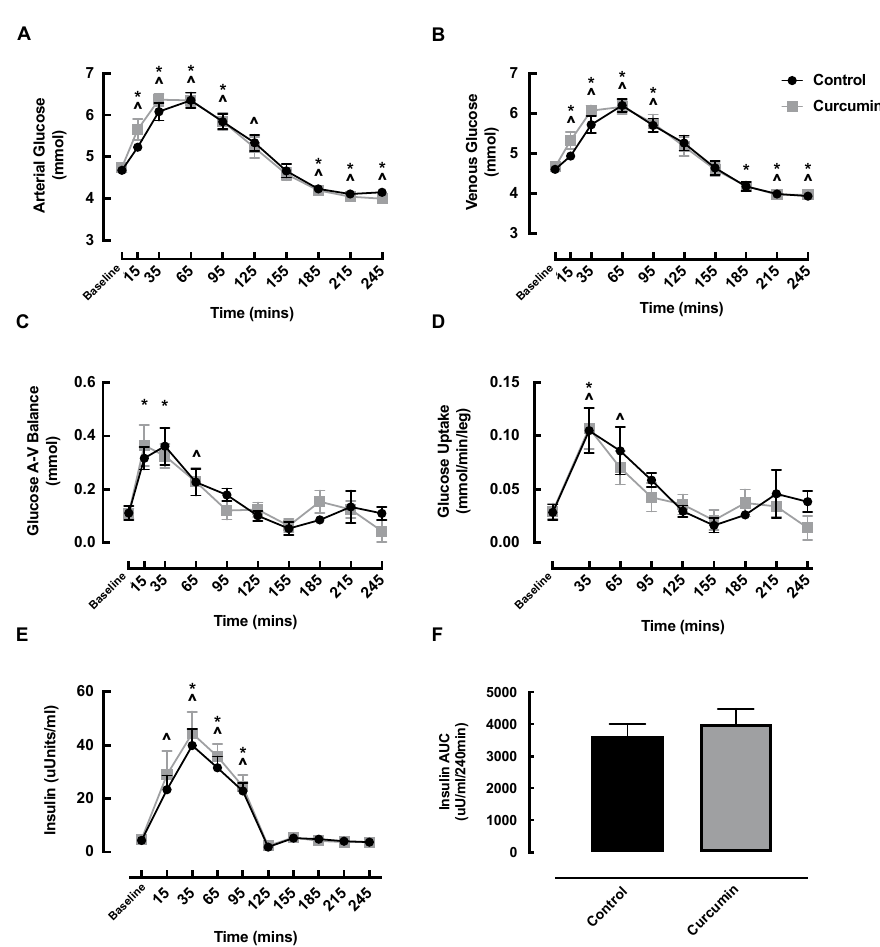
Figure 5. Effects of curcumin alongside oral nutritional supplement feeding on ( A ) arterial glucose; ( B ) venous glucose; ( C ) glucose A-V balance; ( D ) glucose uptake; ( E ) insulin; and ( F ) insulin area under the curve, in healthy older adults. ^ denotes significant difference from control baseline ( p < 0.05); * denotes significant difference from curcumin baseline ( p < 0.05). AUC, area under the curve; A-V, arteriovenous.